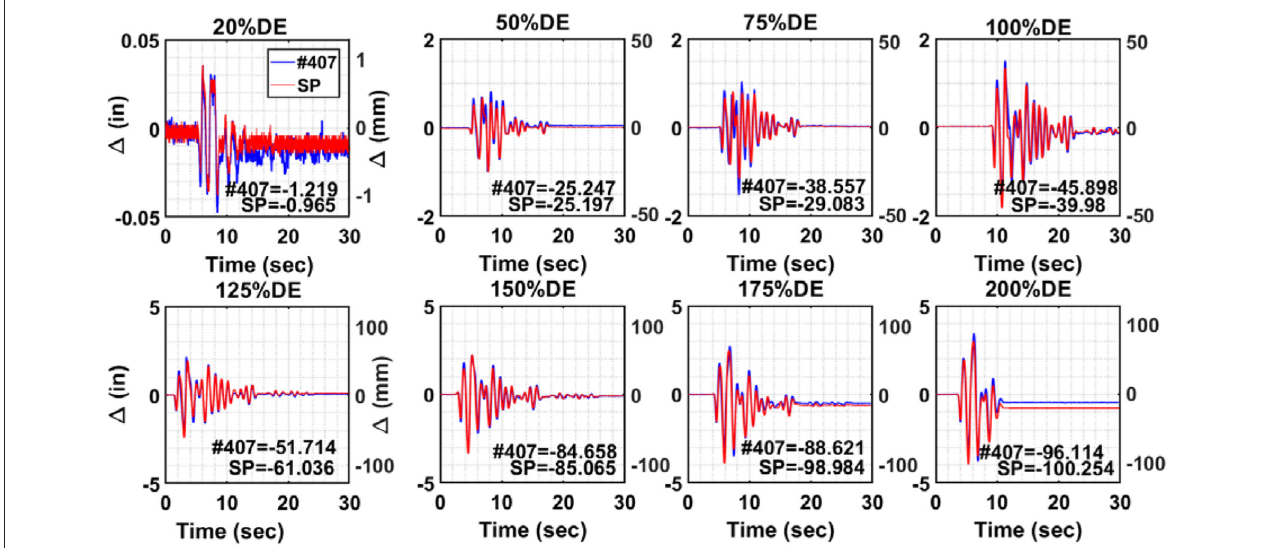
FIGURE 4 | Displacement time histories comparison between target-tracking DIC and string potentiometer.